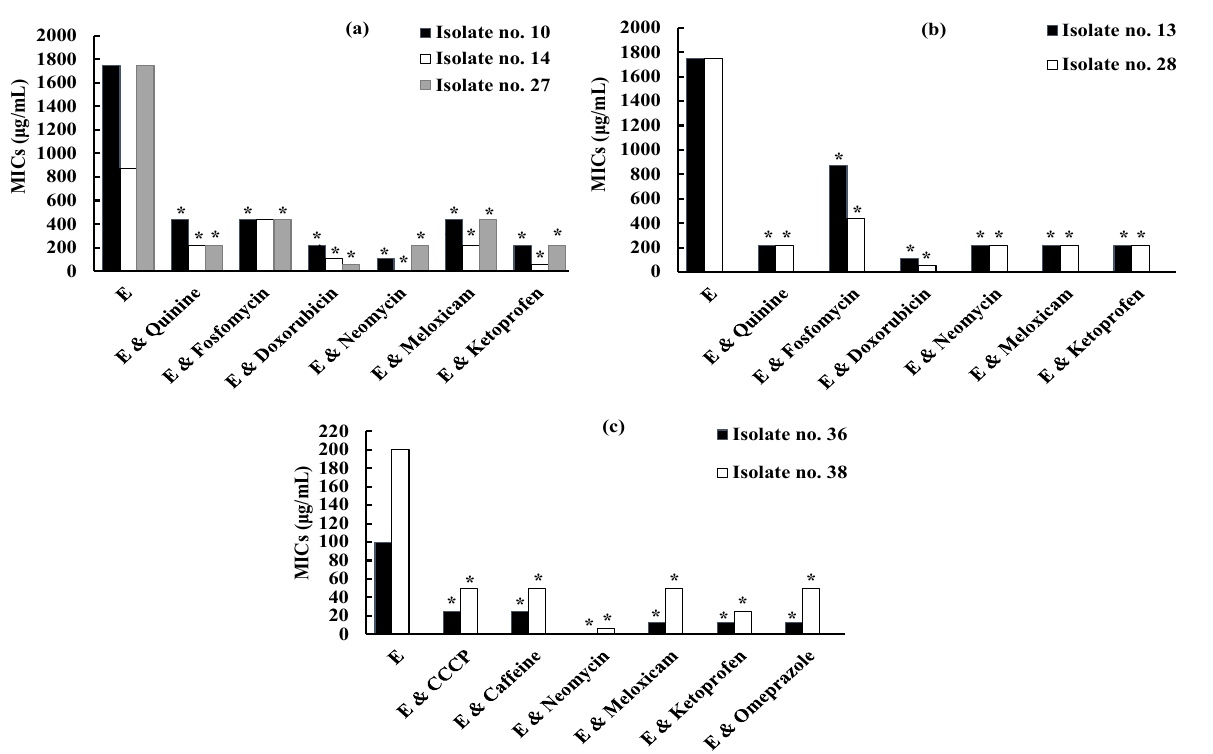
Figure 4. The effect of potential inhibitors on MIC of erythromycin among different MLS B phenotypes of S. aureus isolates. ( a ) The effect of potential inhibitors (quinine, fosfomycin, doxorubicin, neomycin, meloxicam, and ketoprofen) on erythromycin resistance against D phenotype isolates no. 10, 14, and 27. ( b ) The effect of potential inhibitors (quinine, fosfomycin, doxorubicin, neomycin, meloxicam, and ketoprofen) on erythromycin resistance against D + phenotype isolates no. 13 and 28. ( c ) The effect of potential inhibitors (CCCP, caffeine, neomycin, meloxicam, ketoprofen, and omeprazole) on erythromycin resistance against MS phenotype isolates no. 36 and 38. MICs: minimum inhibitory concentrations, E: erythromycin, CCCP: carbonyl cyanide m-chlorophenylhydrazine, *: probability-value ( p -value) is <0.05, which is considered statistically significant. Table 2. Effect of potential inhibitors on erythromycin resistance against S. aureus isolates no. 10, 14, and 27 (D phenotype), isolates no. 13 and 28 (D + phenotype), and isolates no. 36 and 38 (MS pheno- type).